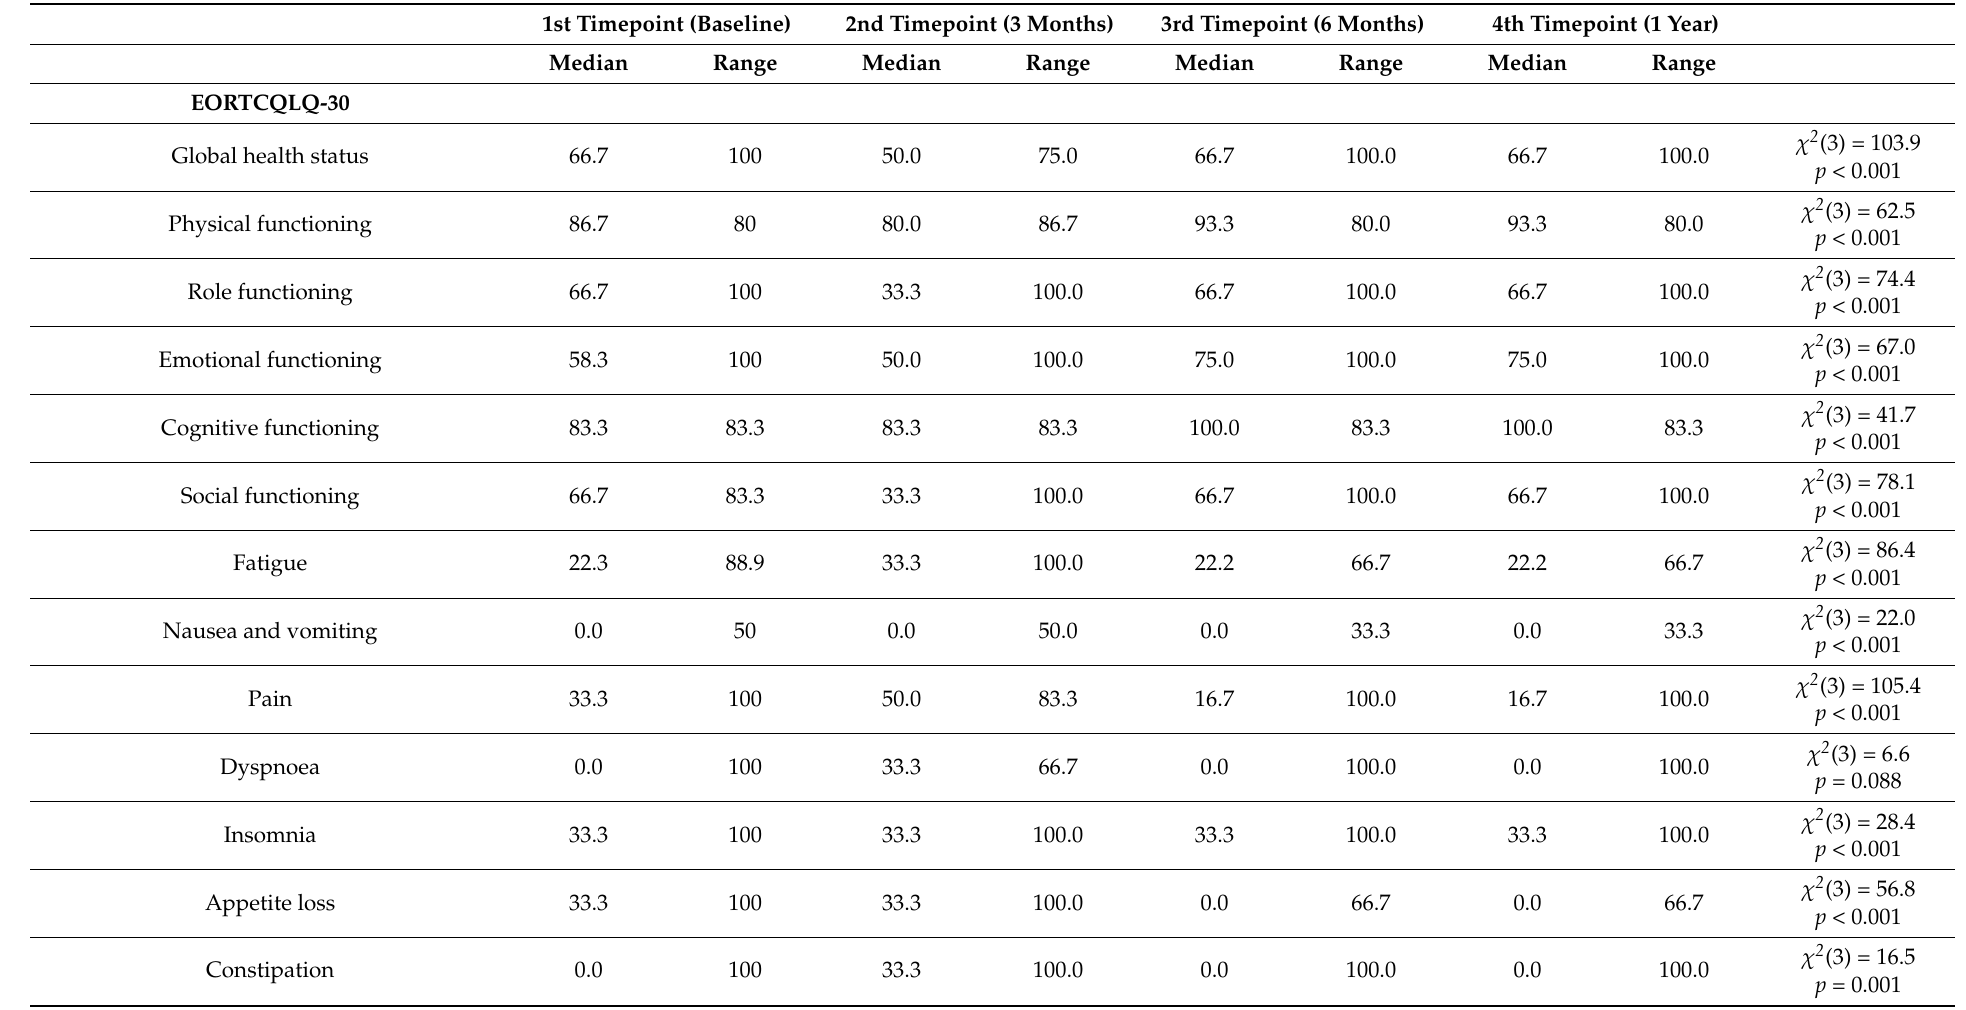
Table 3. QOL subscales in three measurement